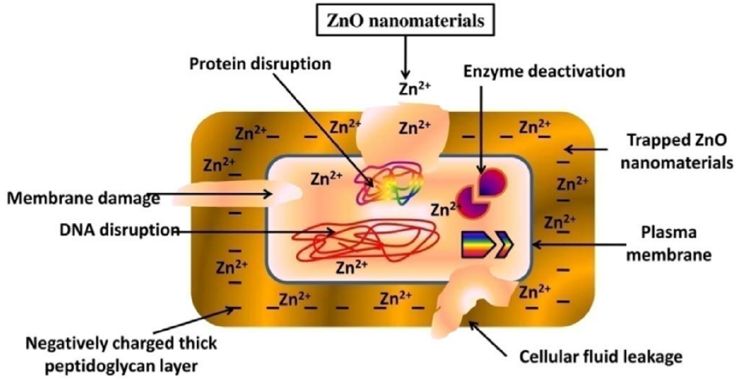
Figure 11. Schematic diagram of cell damage to G+ bacteria by Zn 2+ ions. Reprinted/adapted with permission from Ref. [27]. Copyright© 2022 Elsevier B.V.